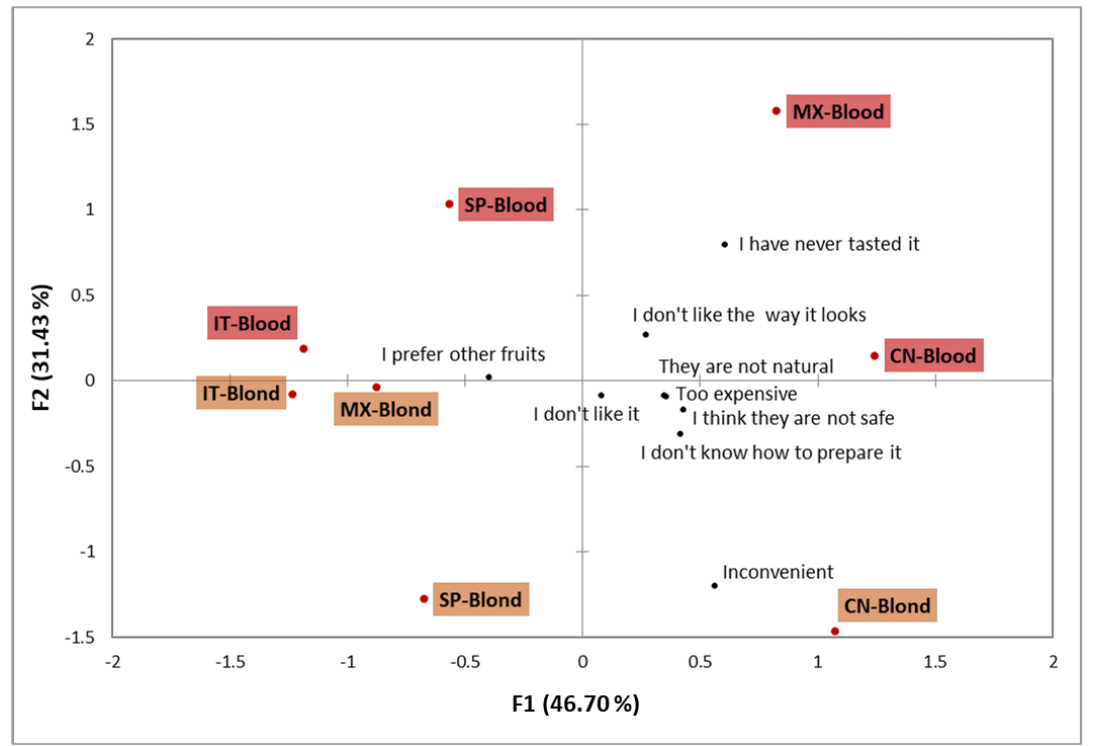
Figure 3. Correspondence analysis for the consumption barriers. The data used to perform the analysis were the percentage of participants (of those who stated not consuming each orange type habitually) who selected each barrier. ES—Spain, IT—Italy, CN—China and MX—Mexico. Italy was the only country for which blond and blood oranges allocation on the CA plot was very close. Thus, taste preferences were indisputably the main barrier for both orange types in